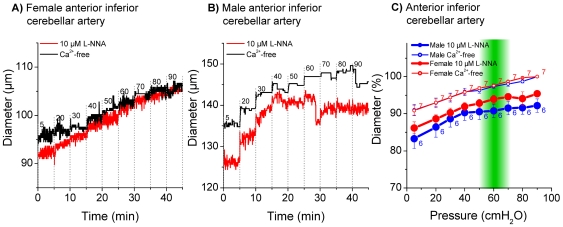
Pressure dependent diameter of female and male anterior inferior cerebellar artery.Original trace of female (A) and male (B) anterior inferior cerebellar artery in 10 µM L-NNA and Ca2+-free solution. Diameter in % in 10 µM L-NNA and Ca2+-free solution (C), % values were normalized to maximal diameter measured in Ca2+-free at 90 cmH2O. 100% = 134.6 µm±6 in Ca2+-free at 90 cmH2O in female animals and 132.8 µm±7.6 in Ca2+-free at 90 cmH2O in male animals.